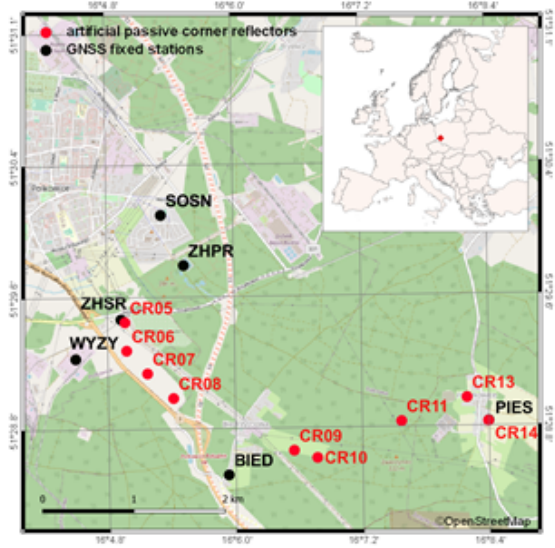
Figure 2. Spatial distribution of artificial passive corner reflectors and GNSS fixed stations in area of interest